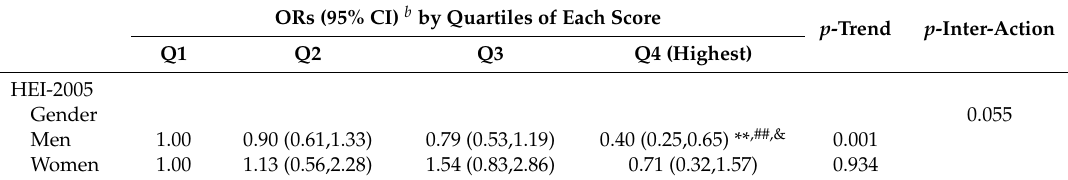
Table 3. Adjusted ORs (95% CIs) of nasopharyngeal carcinoma for quartiles of diet-quality scores by gender a